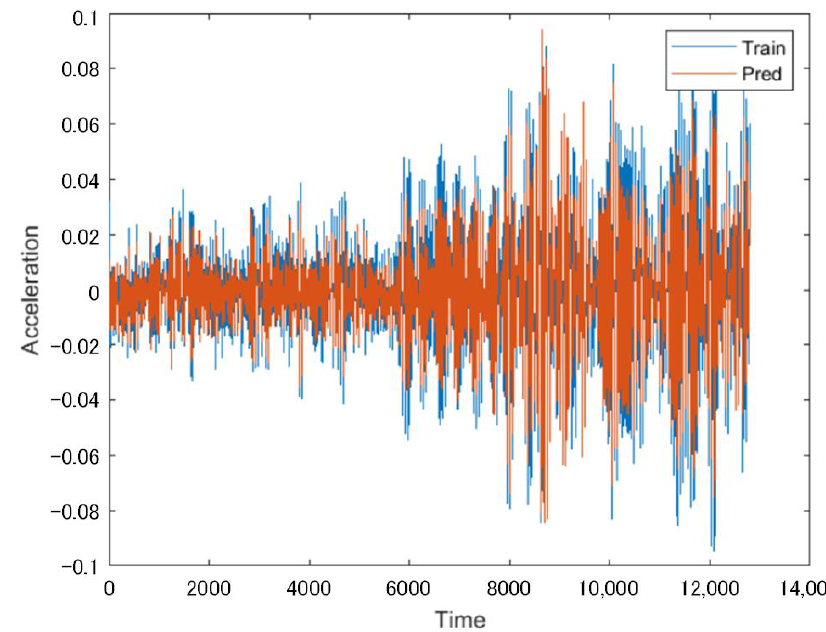
Figure 4. Training results from Channel 7.